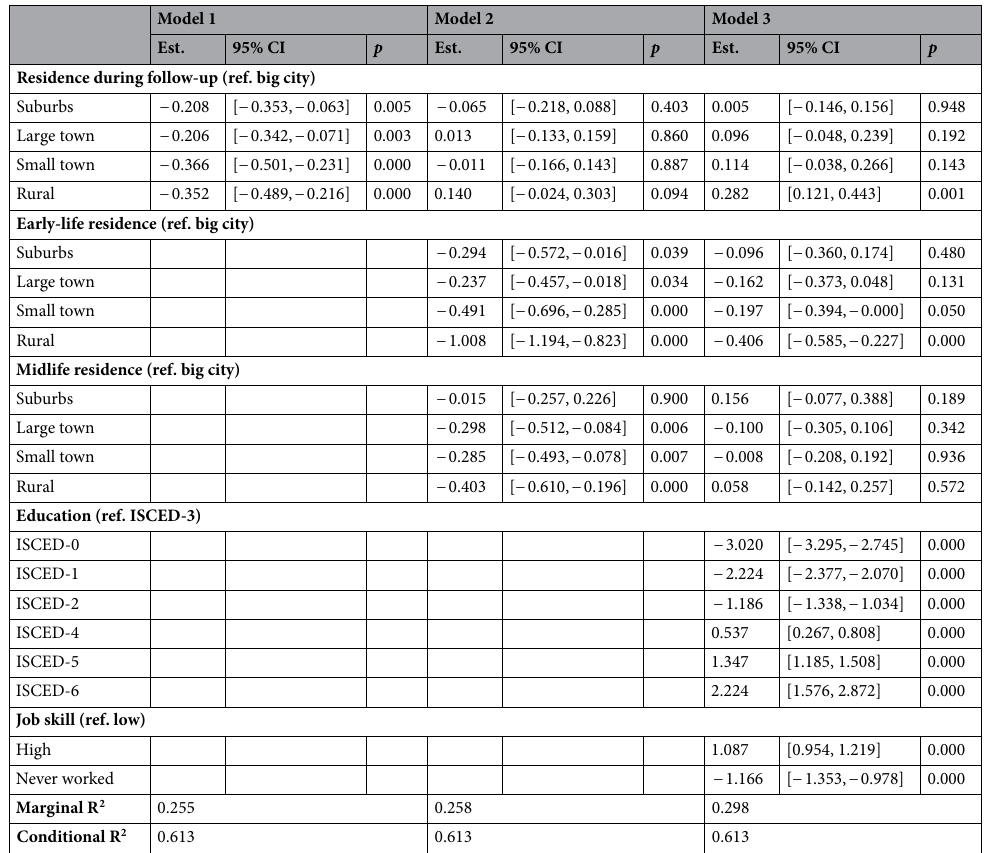
Table 3. Mixed-effects model estimates for verbal fluency. N = 38,165; N observations = 127,377. Adjusted for country of residence, age, sex, self-reported health, depression, and drinking and smoking behaviour. Marginal R 2 is the variance explained by the fixed effects. Conditional R 2 is the variance explained by the entire model including the random effects. CI : Confidence interval calculated using likelihood profile